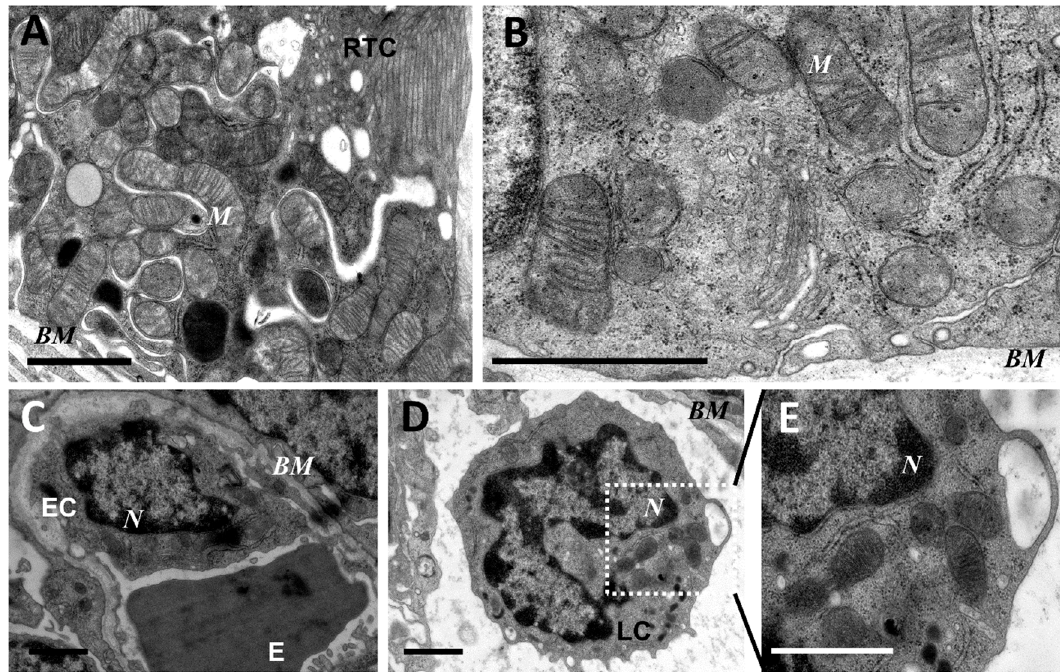
Figure 1. Ultrastructure of mitochondria of renal tubular cells ( A,B ), endothelium ( C ), and leukocytes ( D,E ) in the intact neonatal kidney. Renal tubular cells (RTC), endothelial cells (EC), and leukocytes (LC) contain mitochondria (M) in the orthodox configuration; BM, basal membrane; N, nucleus; E, erythrocyte in the vessel. Scale bar, 1 μ m.